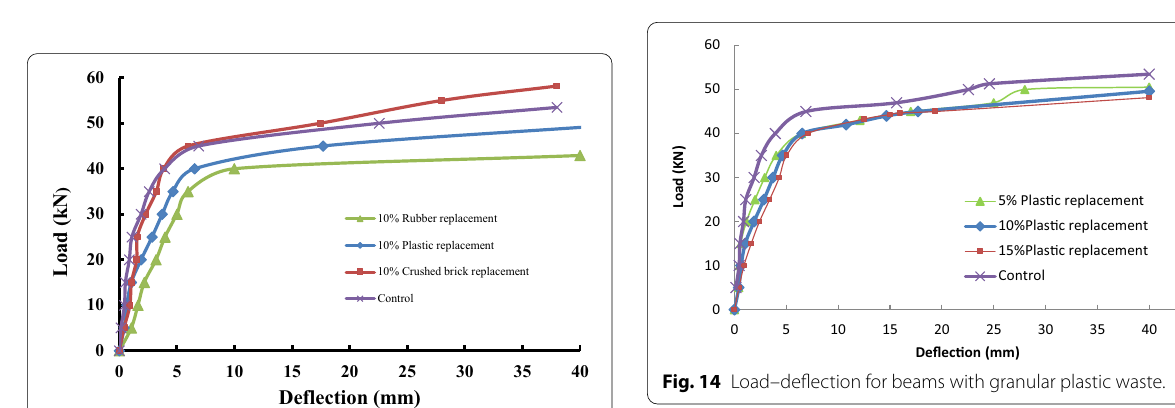
Fig. 11 Load–deflection for beams containing 10% of waste materials.